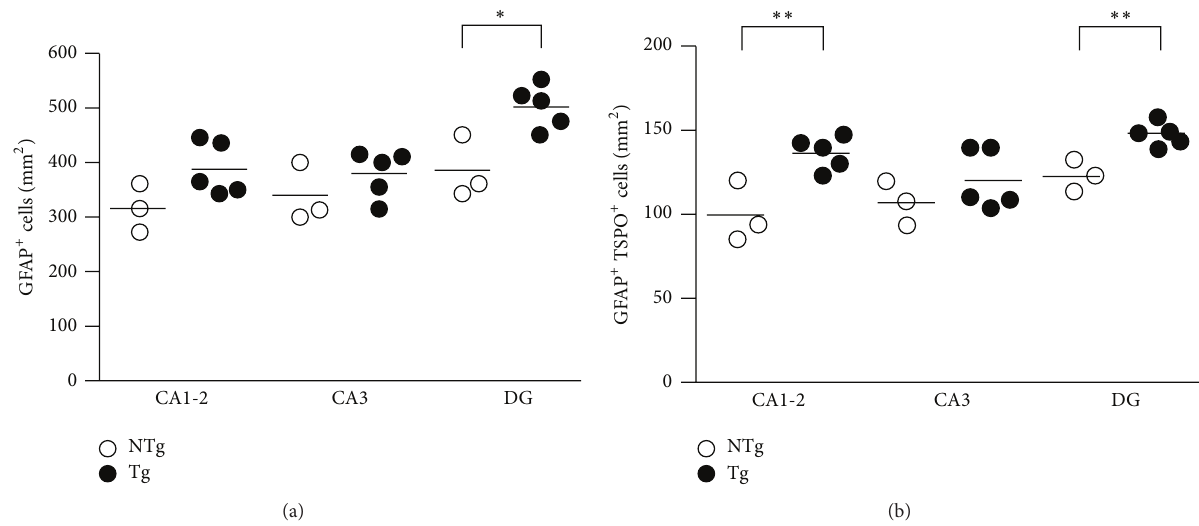
Figure 5: Semiquantitative assessment of GFAP/TSPO colocalization in hippocampal subregions of 3-month-old WT and APPswe/PS1dE9 mice. Quantification of (a) GFAP-IR cells and (b) GFAP/TSPO double-IR cells in CA1-2, CA3, and DG hippocampal subregions in WT ( 𝑛 = 3) and APPswe/PS1dE9 ( 𝑛 = 5) mice. Results were expressed as mean cell count per unit area (mm 2 ) for each mouse; ∗ indicates 𝑝 < 0.05 and ∗∗ indicates 𝑝 < 0.01 . NTg: wild type; Tg: